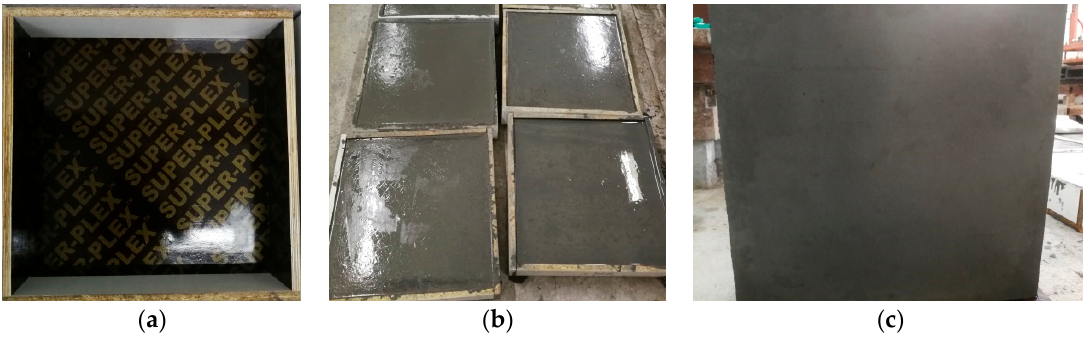
Figure 2. Casting process of specimens for surface appearance test. ( a ) Wooden mold. ( b ) Specimens after casting. ( c ) Specimens after demolding.